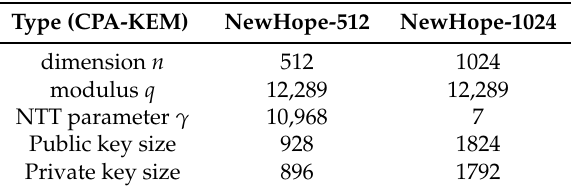
Table 4. Variable information of NewHope.